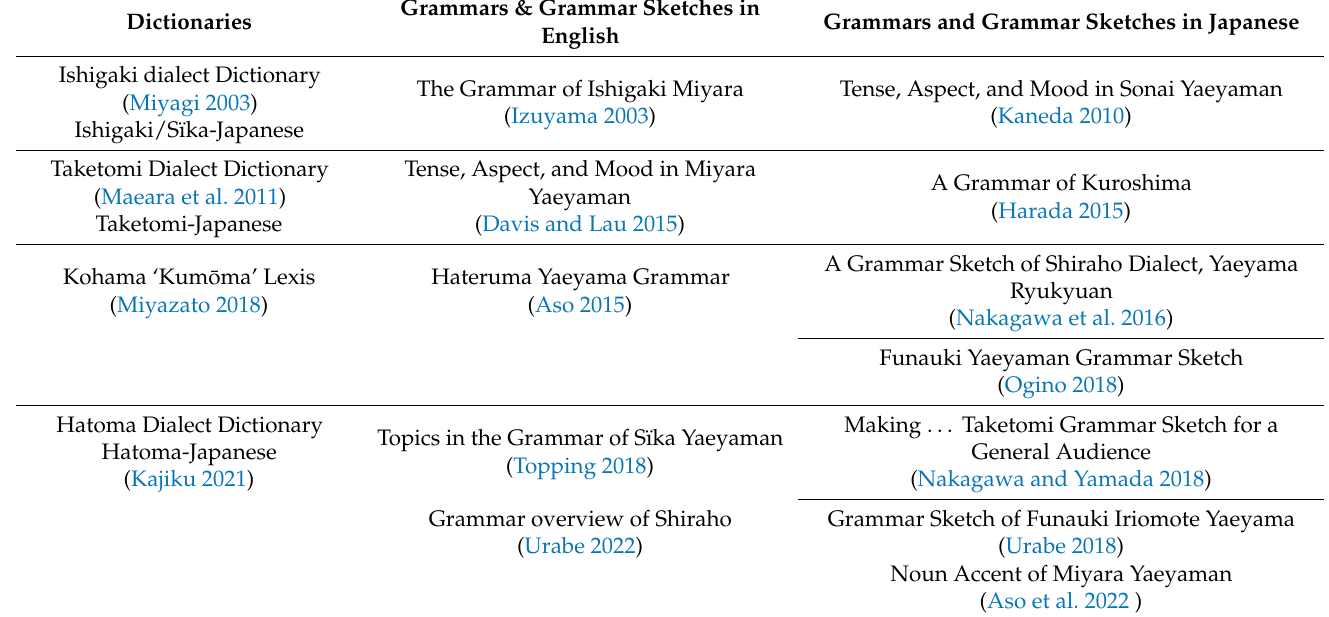
Table 1. Descriptive works on